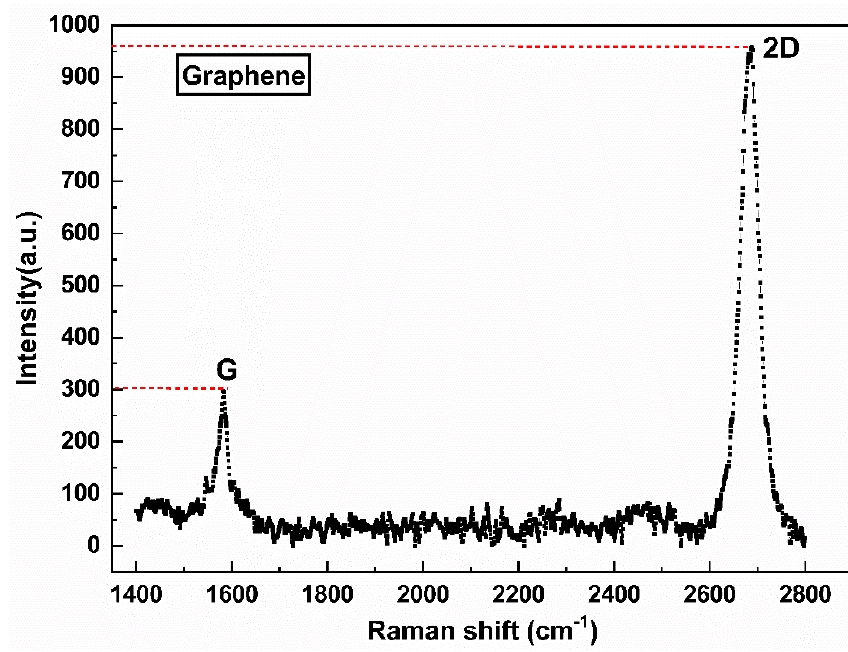
Figure 4. Raman spectra of graphene.